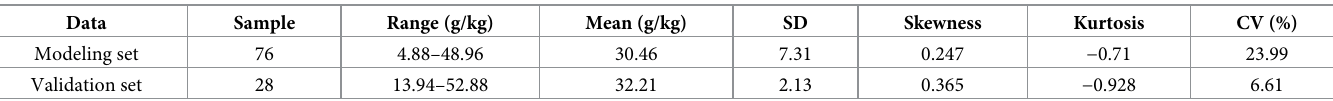
Table 2. Statistical characteristics of soil organic matter content of a Eucalyptus plantation in the red soil area of Huangmian Forest Farm.